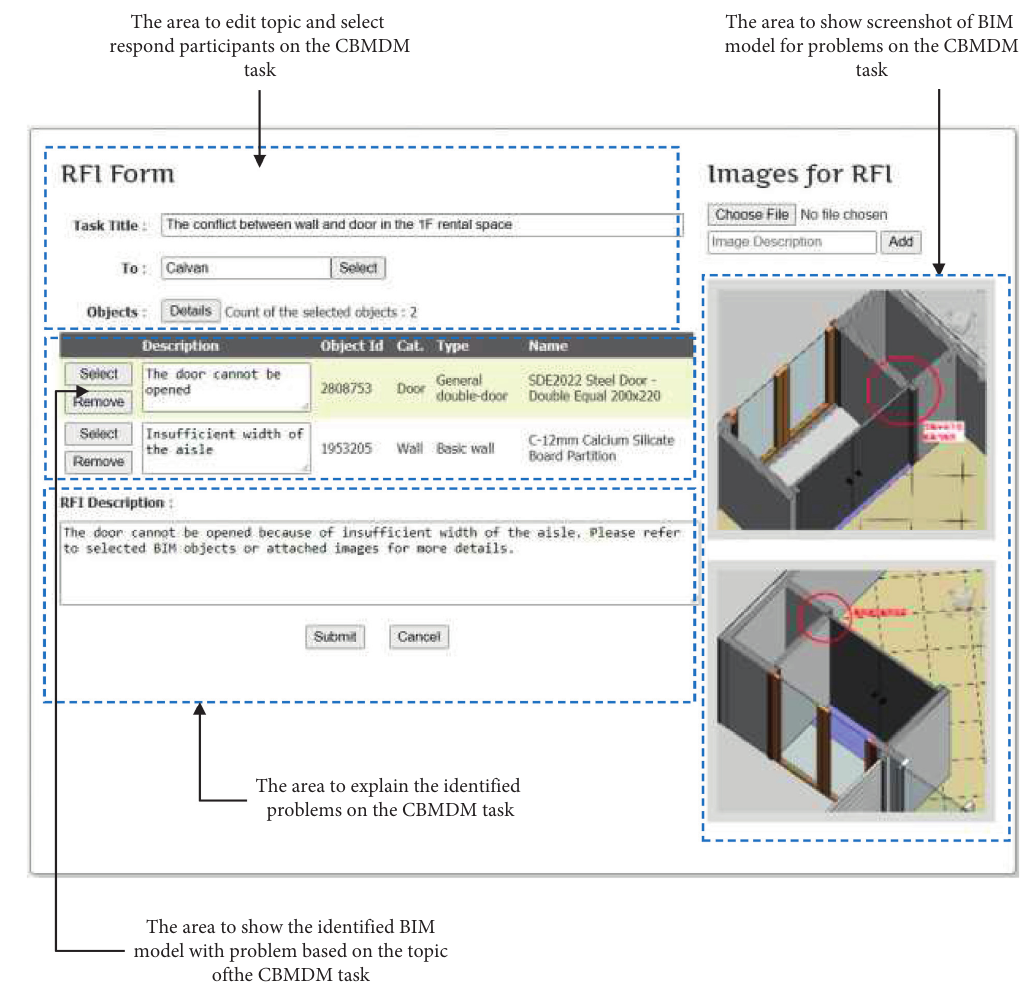
Figure 8: The use of the CBMDM system for CBMDM work in the case study.